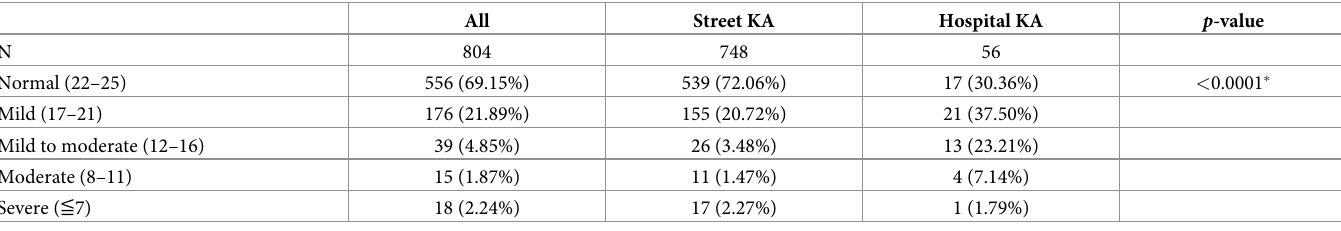
Table 2. Grade of erectile dysfunction by IIEF-5 in all ketamine abusers.